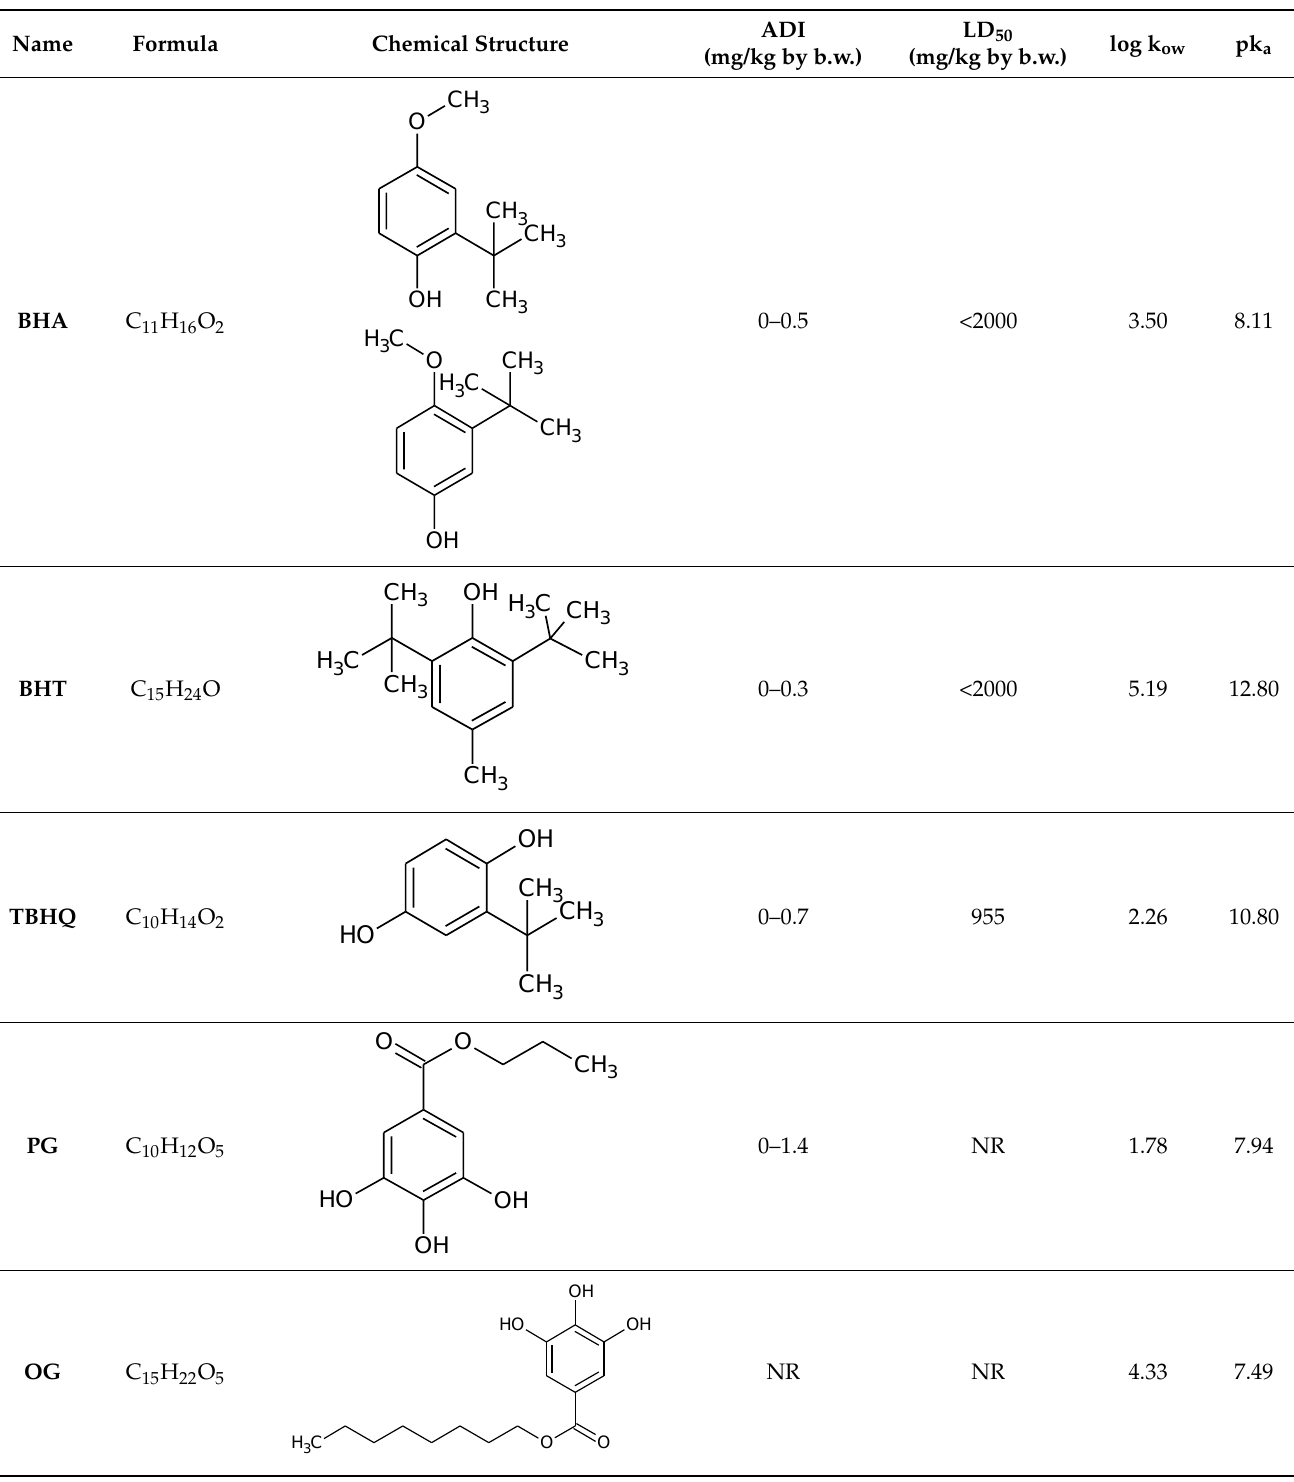
Table 1. Main synthetic phenolic antioxidants with their respective molecular formula, chemical structure, acceptable daily intake (ADI), limit-dose 50 (LD 50 ), partition coefficient (log K ow ), and